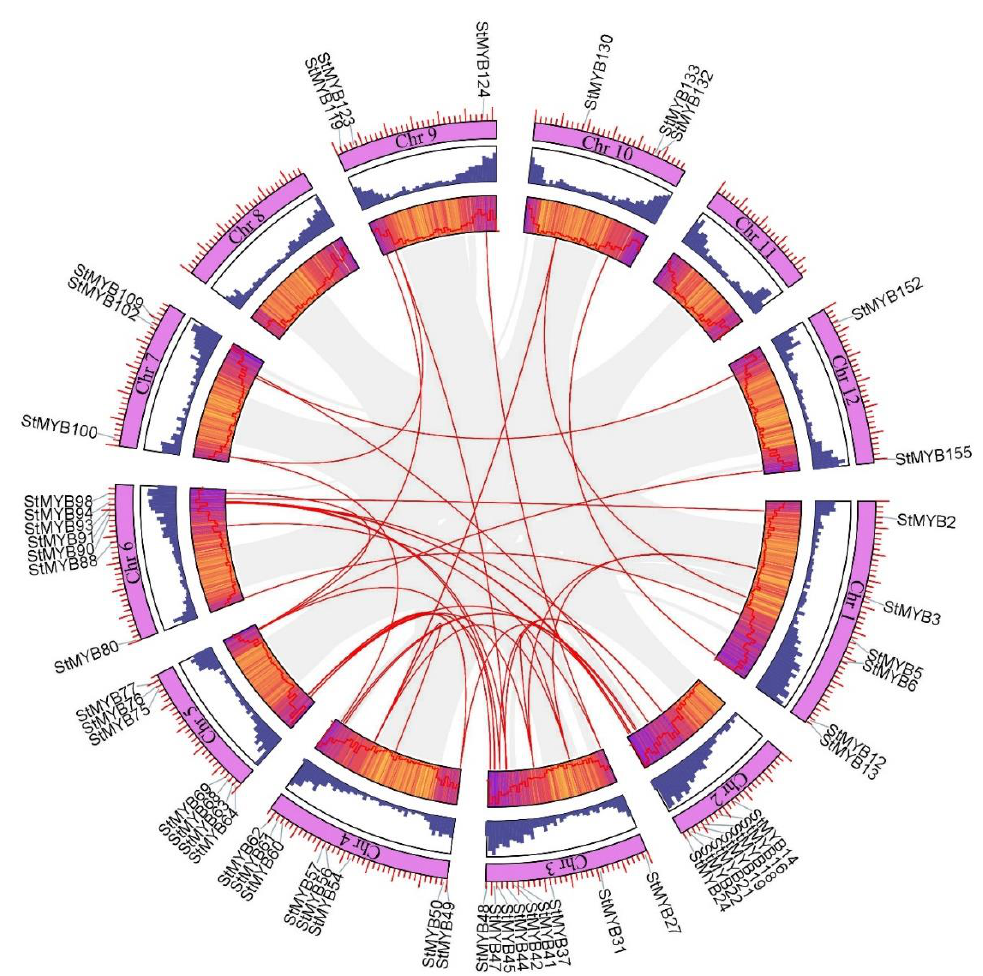
Figure 4. The interchromosomal relationships of the potato MYB genes. Colored lines indicate all syntenic blocks in the potato genome.